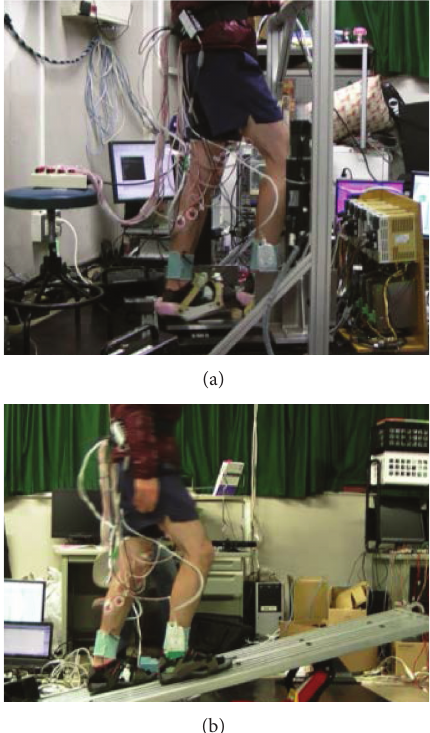
Figure 8: Experiment environment ((a) on GMmini and (b) on a real